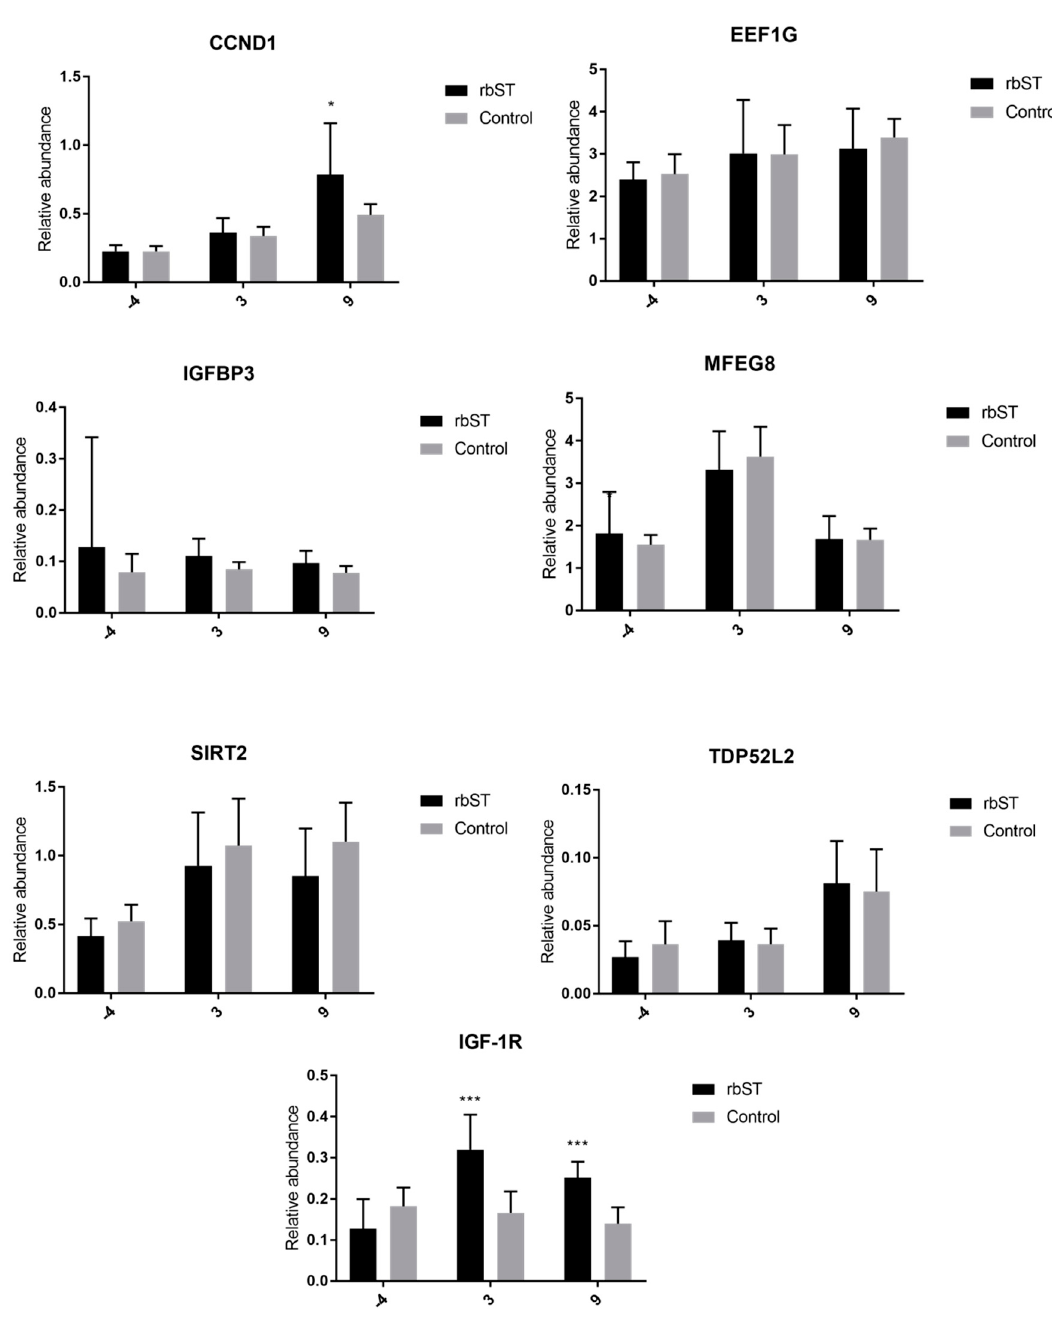
Figure 4. Relative abundance of target genes expressed in hair-follicle samples before rbST administration, and on the third and ninth days after rbST administration. The bars represent the mean value of each group (rbST and control). The value used for each animal is the mean of three replicates. * p < 0.05, *** p < 0.001.